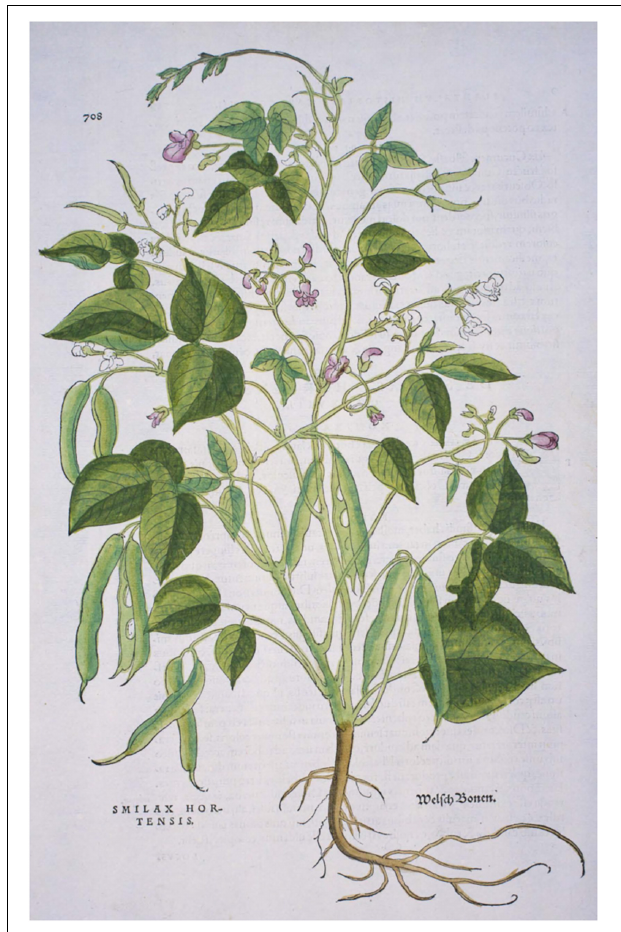
FIGURE 4 | Folio 708 from Leonard Fuchs (1542) Di Historia Stirpium showing an image of common bean ( Phaseolus vulgaris ). Source: Public domain; Hunt Institute for Botanical